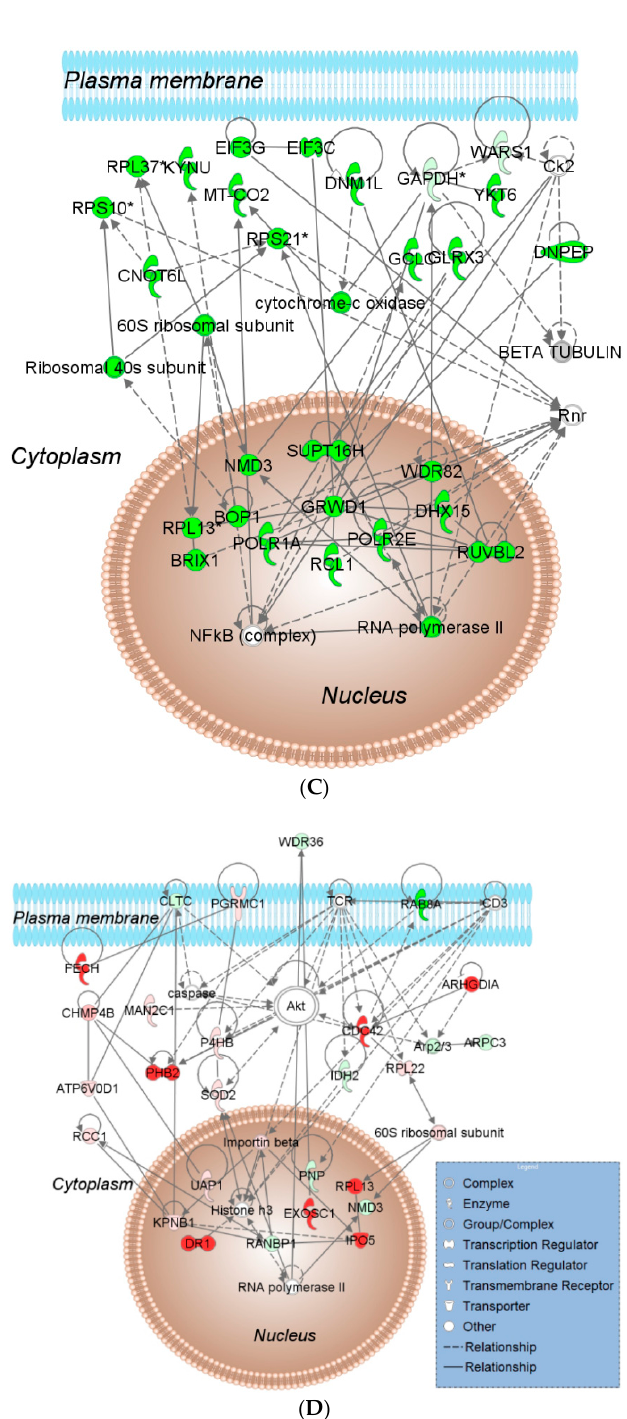
Figure 2. Top networks in S. cerevisiae response to oxidants at 3 min by ( A ) H 2 O 2 : cell death and survival, drug metabolism, small molecule biochemistry; ( B ) CHP: cellular assembly and organization, cell-to-cell signaling and interaction, reproductive system development and function. Top networks in S. cerevisiae response to oxidants at 3 min by ( C ) menadione: protein synthesis, cancer, cell death and survival; and ( D ) diamide: cell cycle, infectious diseases, cellular assembly and organization. The shapes (see legend in blue box) represent molecular classes of the regulated proteins. In the network, red and green colors denote upregulation and downregulation in response to the four treatments, respectively. The intensity of color indicates the relative magnitude of fold change in the protein expression pattern. Solid and dashed lines represent direct and indirect interactions,